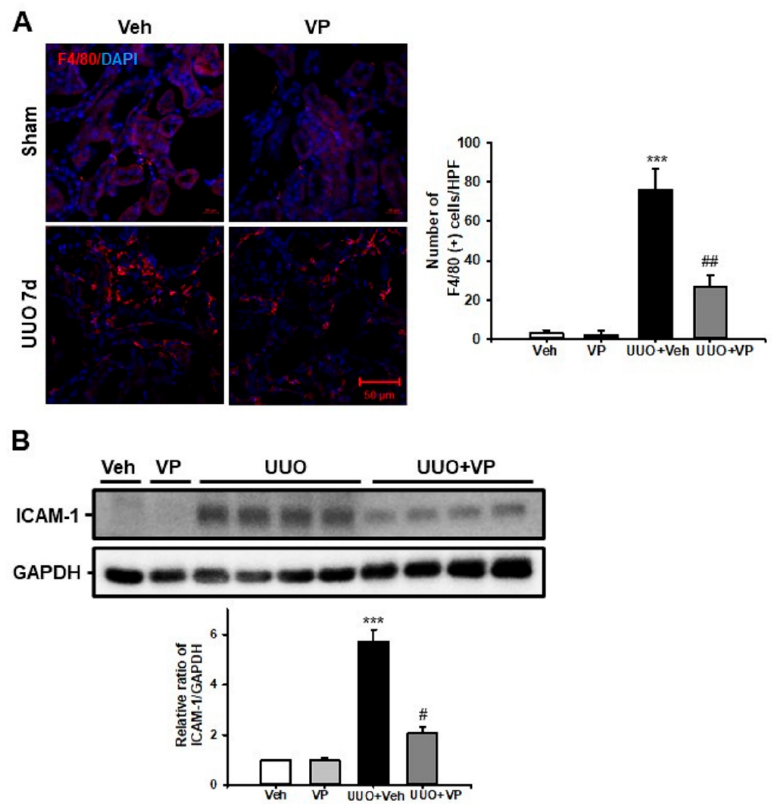
Figure 3. Effect of verteporfin on UUO-induced renal inflammation. ( A ) Representative immunofluorescence staining of F4/80 from the kidneys of sham- and UUO-operated mice treated with vehicle (Veh) or verteporfin (VP). The nuclei were stained with DAPI. The bar graph shows the number of F4/80 positive cells from ten randomly chosen, non-overlapping fields ( n = 10) at a magnification of ×400 ( n = 15/group). Scale bar = 50 µm. Data are expressed as the mean ± SD. *** p < 0.001 versus Veh or VP; ## p < 0.01 versus UUO. ( B ) ICAM-1 expression in kidney tissue from sham- and UUO-operated mice treated with Veh or VP was evaluated by Western blotting. Data from the densitometric analysis are presented as the relative ratio of each protein to GAPDH. The relative ratio measured in the kidneys of sham-operated mice treated with Veh is arbitrarily presented as 1. Data are expressed as the mean ± SD. *** p < 0.001 versus Veh or VP; # p < 0.05 versus UUO; Veh, vehicle; VP, verteporfin; Sham, sham-operated mice; UUO, unilateral ureteral obstruction operated mice; ICAM-1, intercellular adhesion molecule-1; DAPI, 4’,6-diamidino-2-phenylindole; GAPDH, glyceraldehyde 3-phosphate